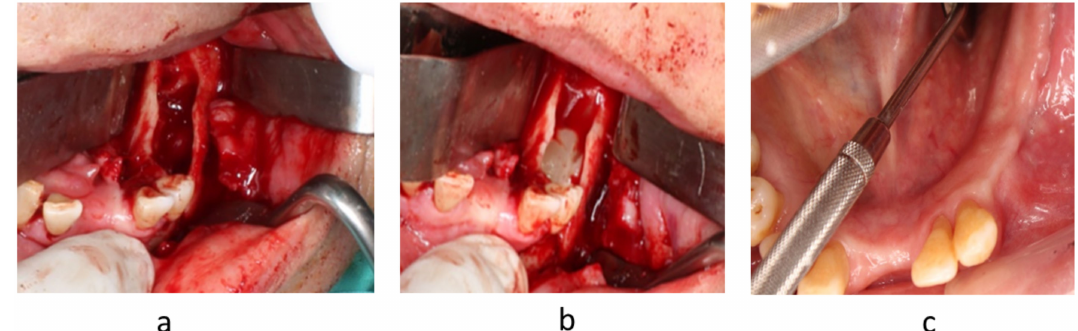
Figure 2. ( a ) Patient #8: Bone defect exposed after debridement, curettage, and peripheral ostectomy; ( b ) the platelet-rich fibrin (PRF) clot placed into the bony defect; ( c ) healing after 2